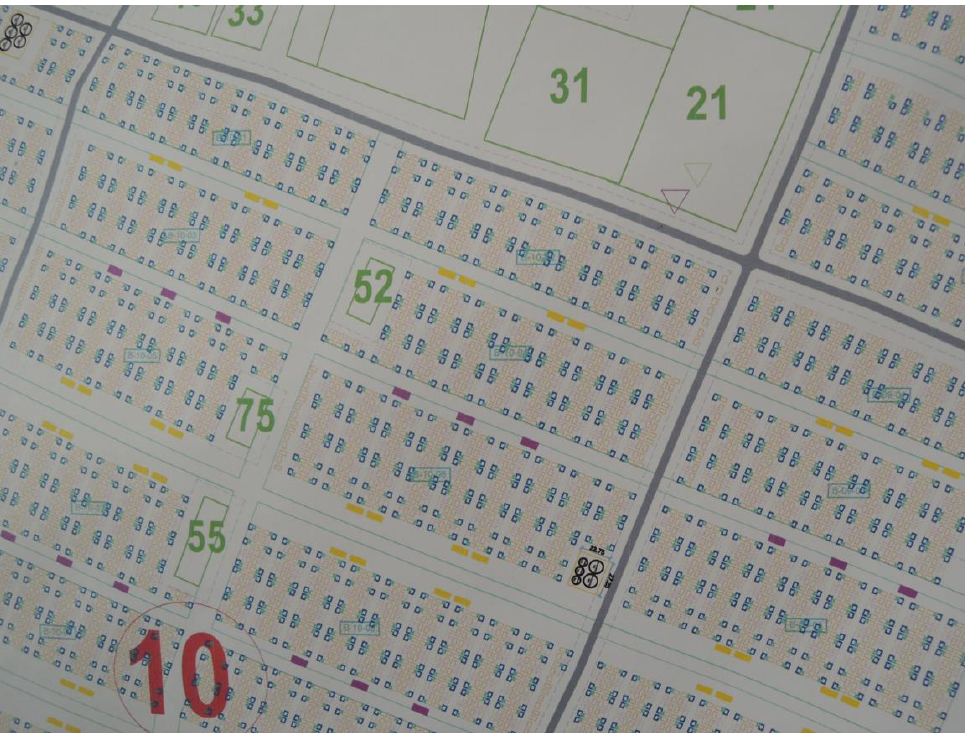
Figure 2. Zaatari camp as planned by UNHCR (Source: Author, 2015).